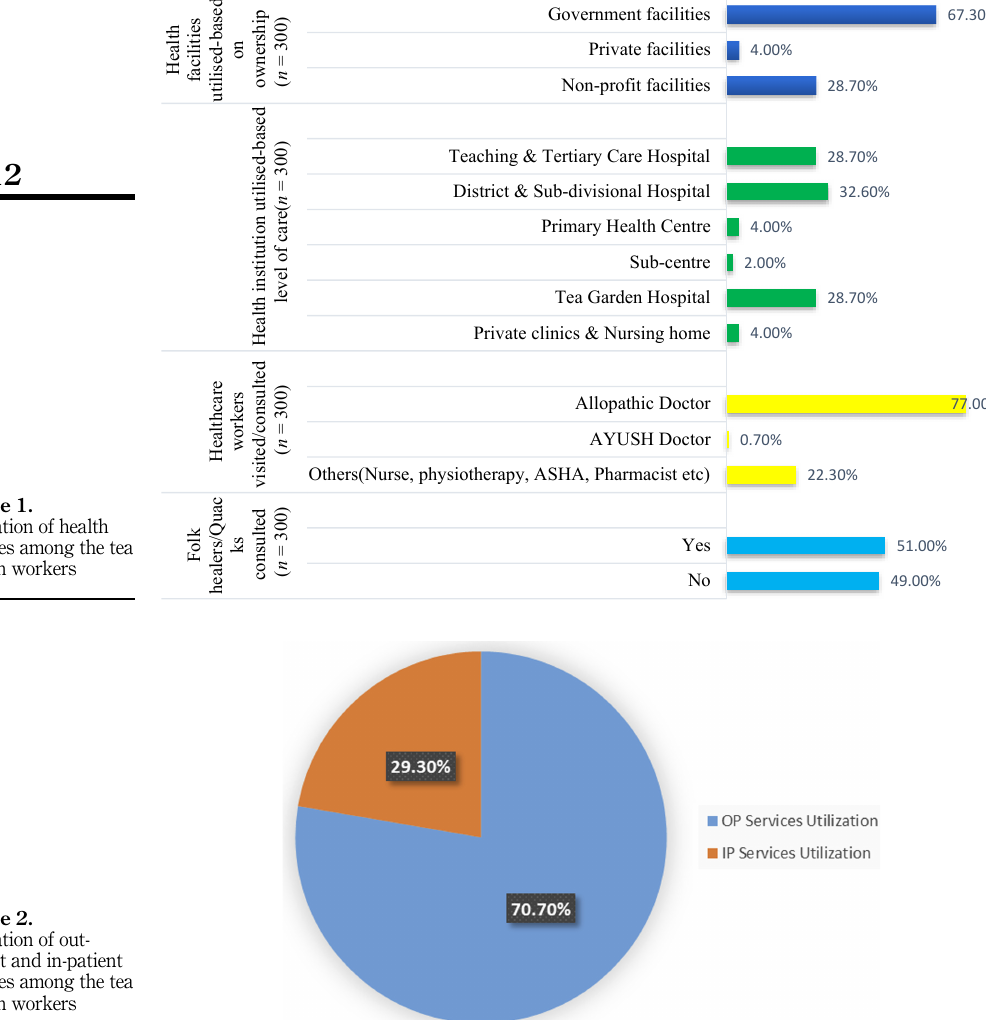
Figure 1. Utilisation of health services among the tea garden workers